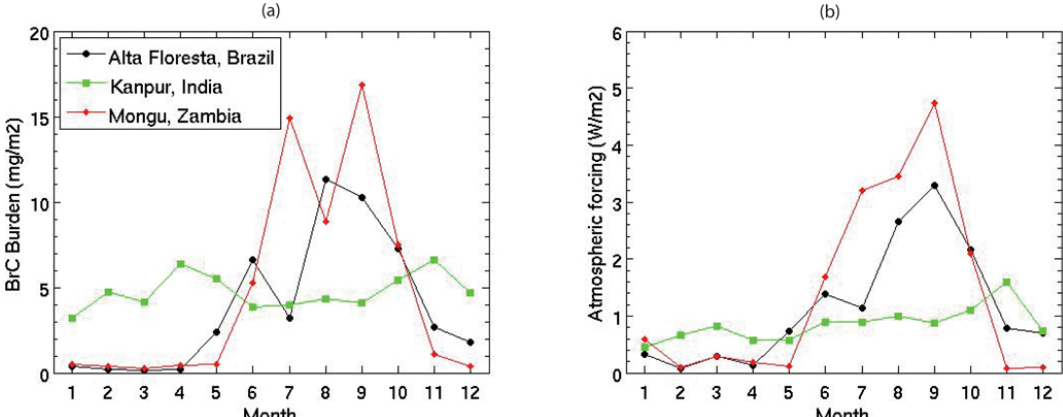
Fig. 10. Seasonal variations in the model predictions of (a) BrC burden (mgm − 2 ) and (b) atmospheric absorption (Wm − 2 ) due to the STR BrC at Alta Floresta, Brazil (56.1 ◦ W, 9.87 ◦ S), Kanpur, India (80.23 ◦ E, 26.51 ◦ N), and Mongu, Zambia (23.15 ◦ E, 15.25 ◦